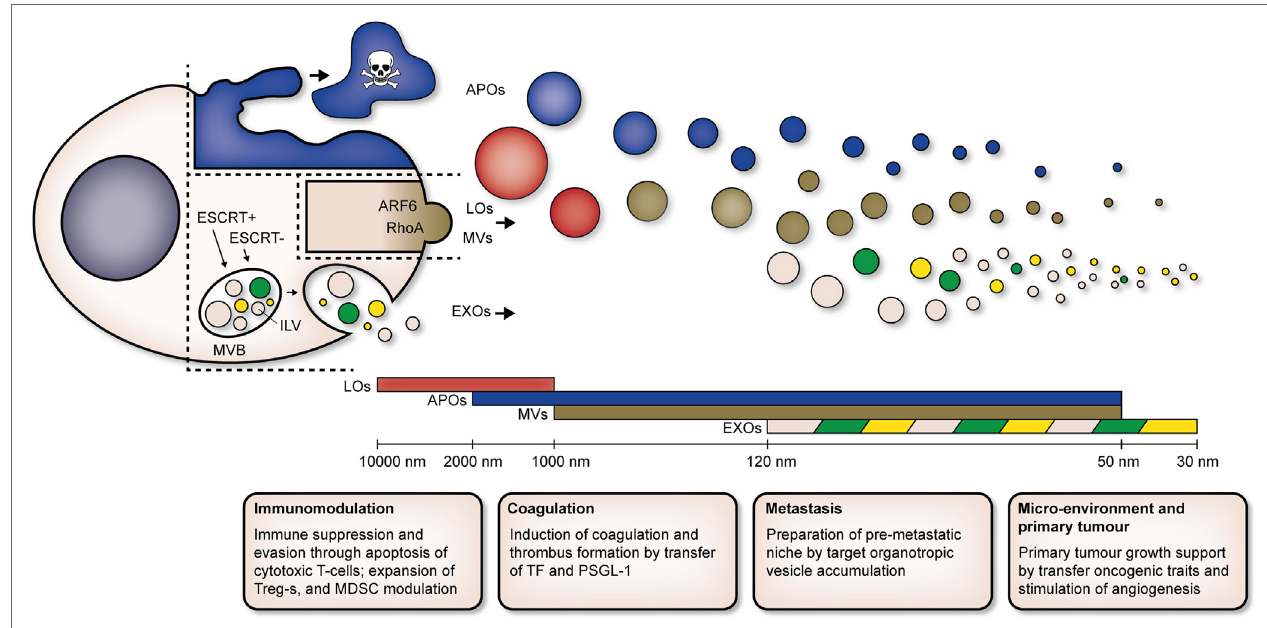
FiGURe 1 | Cells release heterogeneous populations of EVs with overlapping sizes. APOs (blue) are released by cells undergoing apoptosis. LOs (red) and MVs (brown) are derived directly from the plasma membrane, ARF6 and RhoA are key players in biogenesis of MVs. EXOs (pink) are derived from intracellular endosomal compartments. ILVs form within MVBs and are subsequently released upon fusion of MVBs with the plasma membrane. Both ESCRT-dependent (ESCRT + ) and -independent (ESCRT − ) pathways are involved in biogenesis of EXOs. Unique subpopulations of EXOs (as indicated by green and yellow EVs) have been identified. Abbreviations: MVB, multivesicular body; ILV, intraluminal vesicle; ESCRT + , endosomal sorting complex required for transport-dependent; ESCRT, endosomal sorting complex required for transport-independent; ARF6, ADP-ribosylation factor 6; RhoA, Ras homolog gene family, member A; EVs, extracellular vesicles; APOs, apoptotic bodies; LOs, large oncosomes; MVs, microvesicles; EXOs, exosomes; Tregs, T regulatory T cells; MDSCs, myeloid-derived suppressor cells; TF, tissue factor; PSGL-1, P-selectin glycoprotein